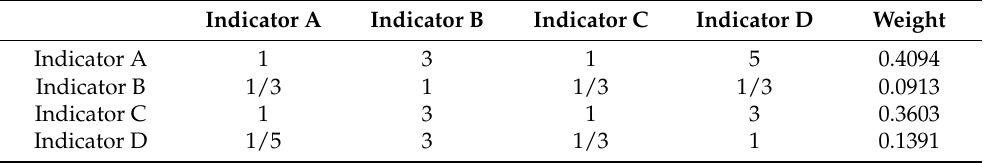
Table 7. Judgment matrix and weights of the criterion layer.